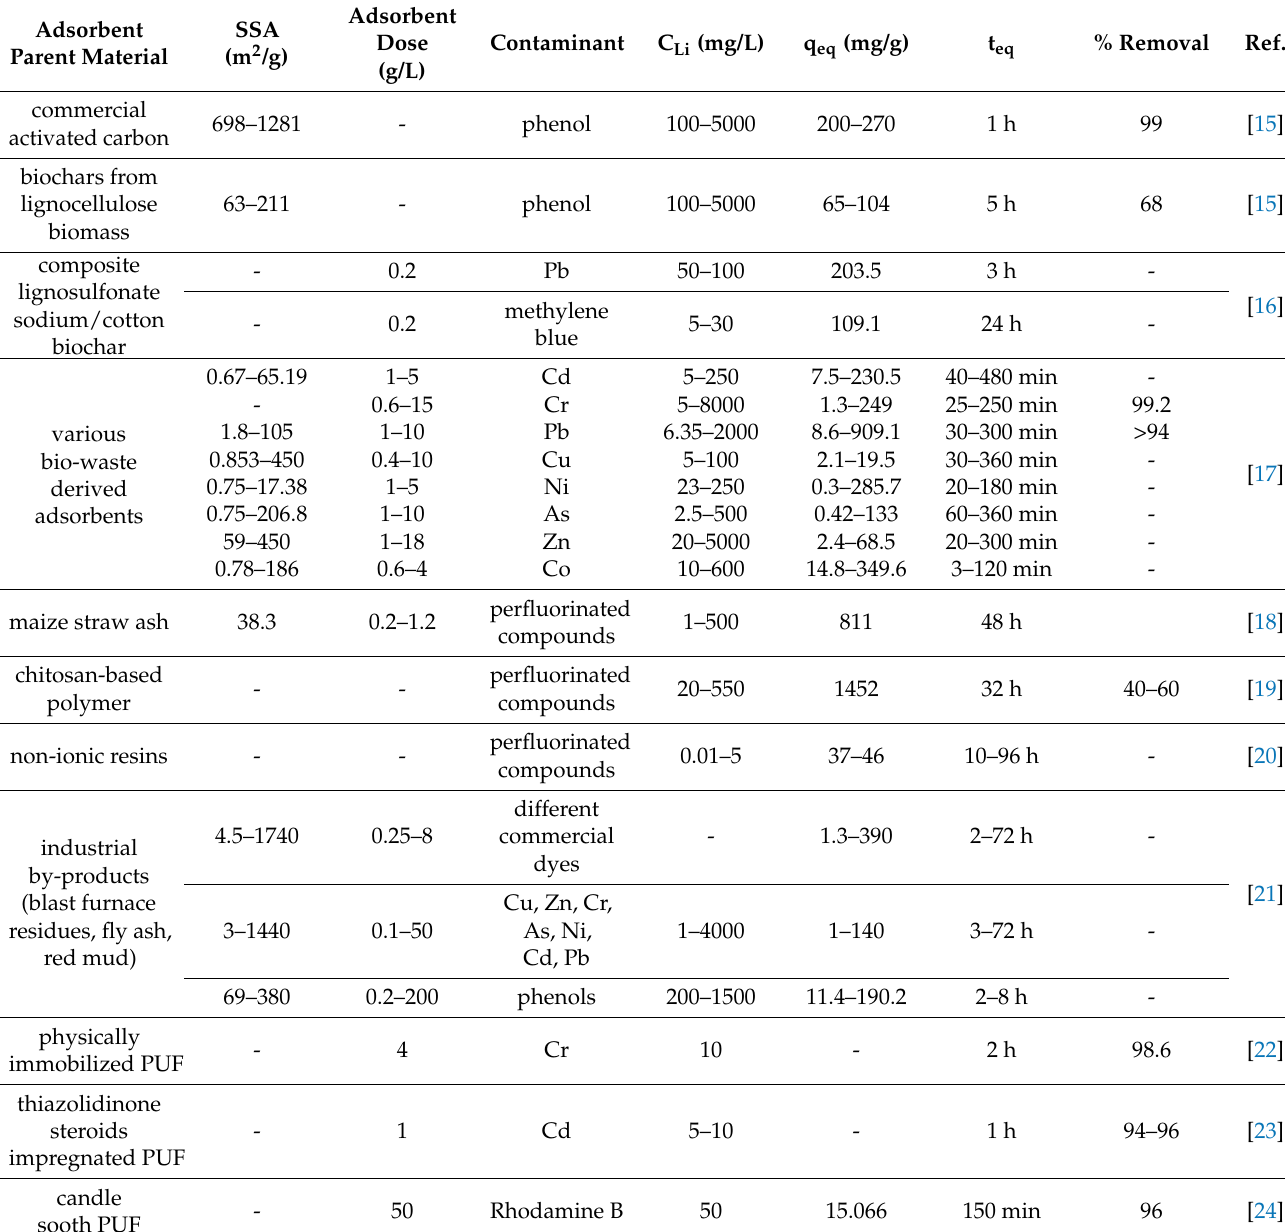
Table 1. Overview of studies describing the properties and performances of commercial and novel adsorbents towards different contaminants (SSA: specific surface area; C Li : initial concentration in the liquid phase; q eq : amount adsorbed on the solid phase; t eq : contact